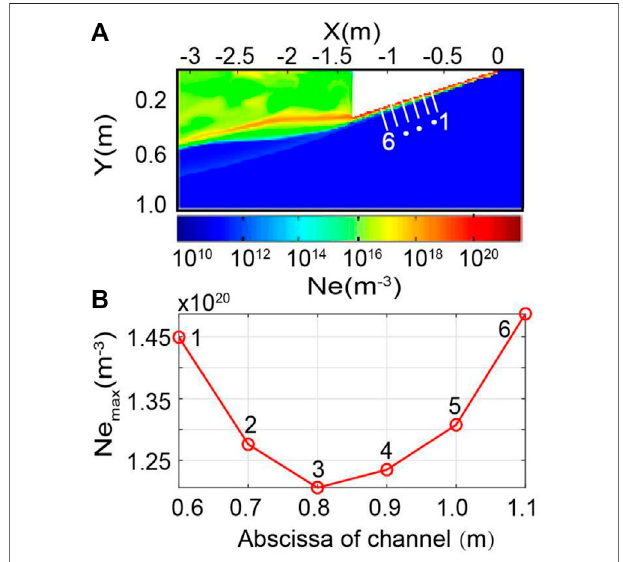
FIGURE1|(A) Schematicdiagram ofsidechannelsofplasmasheathof a sharp-coned reentry vehicle, (B) Maximum electron density of each channel at t = 1 ms.